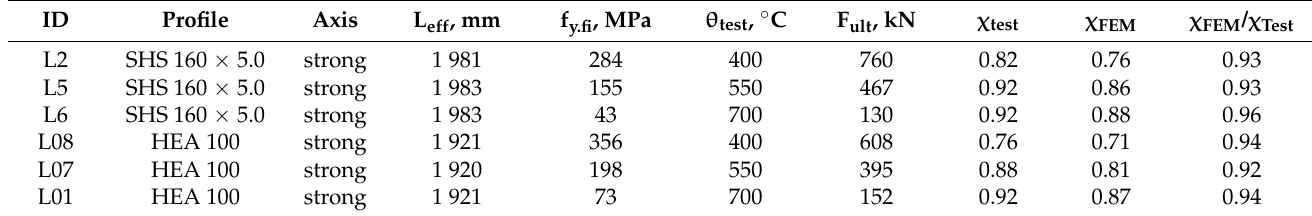
Figure 5. Validation of the numerical results against the test results. Table 3. Validation of the numerical results against the test series from ETHZ [25].